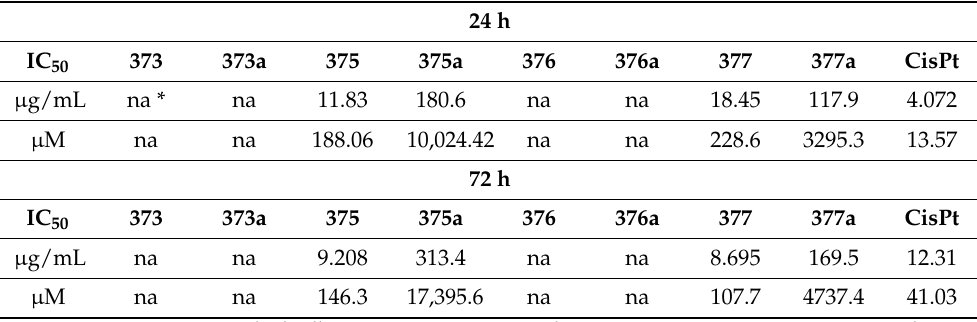
Table 1. Effect of studied NSAIDs and their rhenium derivatives on the viability of Ishikawa cell line after 24- and 72-h treatment; the results were expressed as the mean IC 50 ( µ M; µ g/mL) from three independent experiments; CisPt–cisplatin.